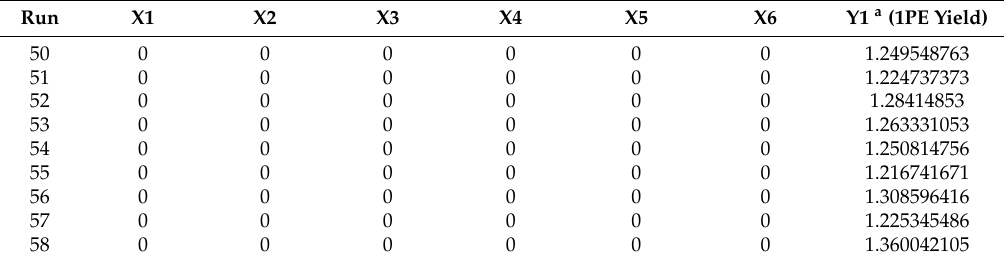
Figure 3. Standard 1PE curve using ethyl n -decanoate as an internal standard (IS). X -axis shows the GC-MS peak area ratio of 1PE to the IS. Y -axis shows 1PE content. The IS content was 5 nmol. 1PE can be used as a fragrance in the food flavoring and cosmetic industries and as an intermediate in the pharmaceutical industry. Some microorganisms including the Azoarcus sp. strain EbN1 and Geotrichum candidum NBRC 4597 were found to contain enzymes being able to convert acetophenone to 1PE [22,23]. However, such enzymes were not characterized in plants. In our previous study, using traditional protein chromatography, the two types of partially purified enzymes were proposed to be responsible for formations of ( R )-1PE and ( S )-1PE from acetophenone, respectively [20]. Furthermore, the major 1PE synthetic enzymes were to produce the ( R )-1PE of tea flowers in vivo [17]. The present study characterized the in vitro properties of 1PE synthetic enzymes from tea flowers, which showed a higher activity under acidic condition and a higher temperature (Figures 1 and 2). In addition, a medium pH extraction buffer was used to obtain 1PE synthetic enzymes with high activity (Figure 1). Although 1PE was accumulated in tea flowers in contrast to other Camellia plants [17], it is unfeasible to extract and isolate “natural 1PE” directly from tea flowers because doing so has a high cost, is time consuming, and produces a low yield. Therefore, 1PE synthetic enzymes in tea flowers can be used to produce “natural 1PE” in vitro. Figure 5 shows that 1PE production using enzymes from tea flowers was significantly higher than that from tea flowers (Figure 5). It is important to improve the performance of the enzyme synthesis systems and to increase the yield of the target product without increasing the cost. Response surface methodology is a combination of statistical and mathematical techniques by which a response is affected by several variables, and the aim is to optimize this response [24]. In recent years, response surface methodology has been widely applied to the optimization of biochemical processes, such as the enzymatic synthesis of fatty esters [25], alkaline protease production from Bacillus mojavensis in a bioreactor [26], the synthesis of butylgalactoside using β -galactosidase from Aspergillus oryzae [27], bioconversion from 2-phenylethanol to phenylacetaldehyde in a two-phase fed-batch system [28], the production of cholesterol oxidase